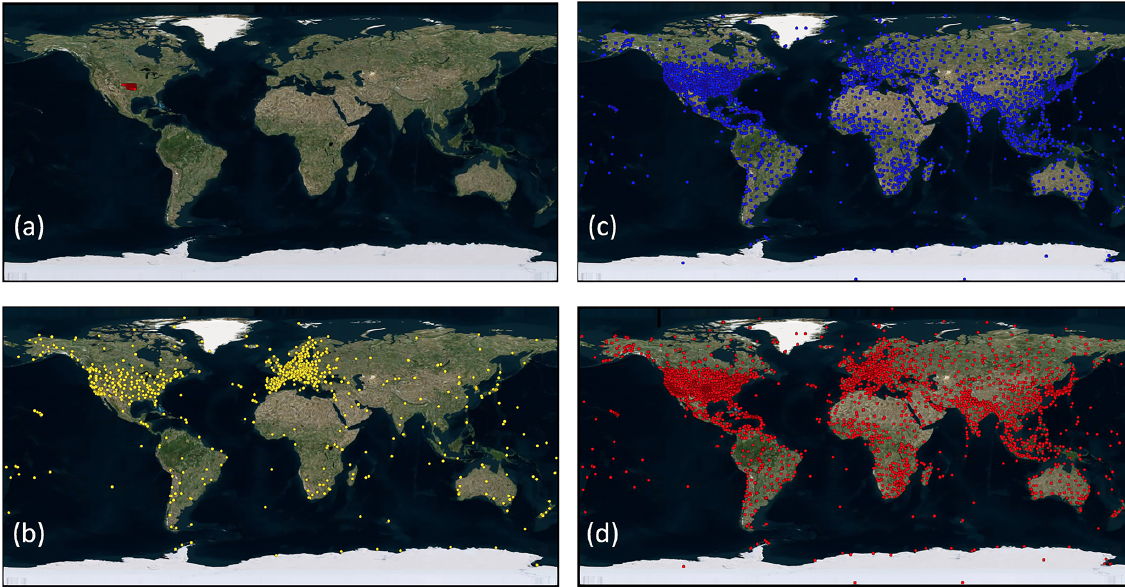
Figure 7. Same as Fig. 6 but for the documentation category of the